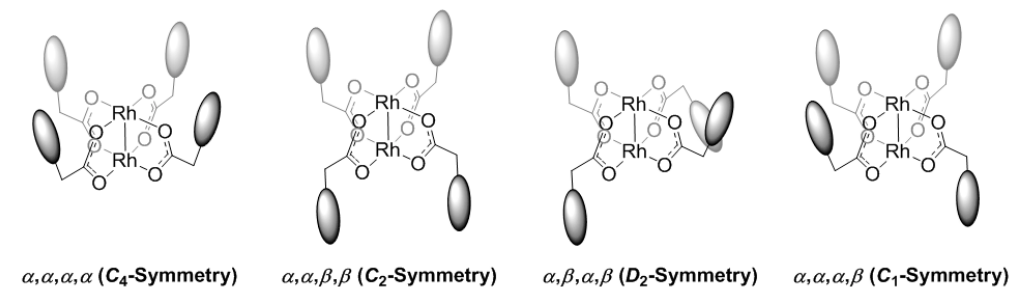
Figure 1. Main arrangements of ligand’s blocking groups around the dirhodium(II) core and their point groups (the sterically blocking groups around the rhodium active sites are depicted as ovals)